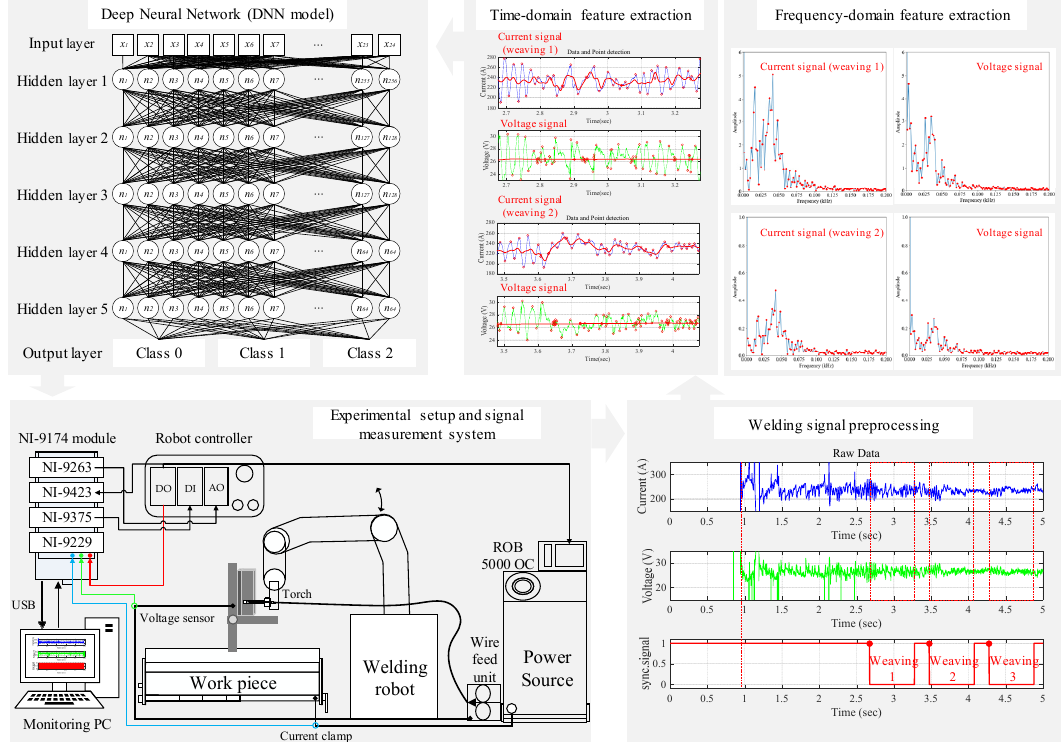
Figure 6. Proposed weld gap detection and welding quality control system.